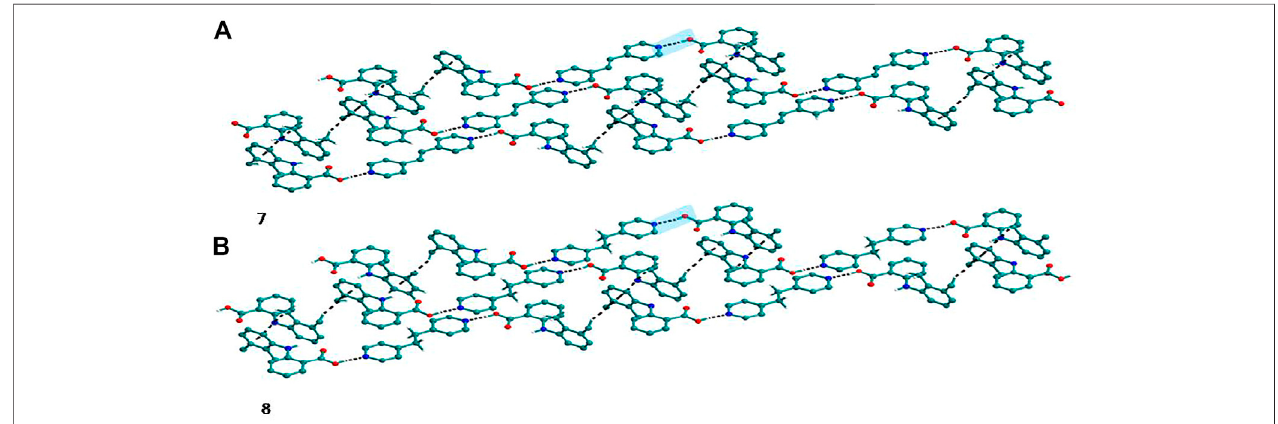
FIGURE 4 | (A) Mef ─ bpe ─ Mef trimers are connected with other trimers via C ─ H ··· π interaction in 7 . (B) Isostructural 8 shows the same types of Mef ─ bpee ─ Mef trimers interactions.